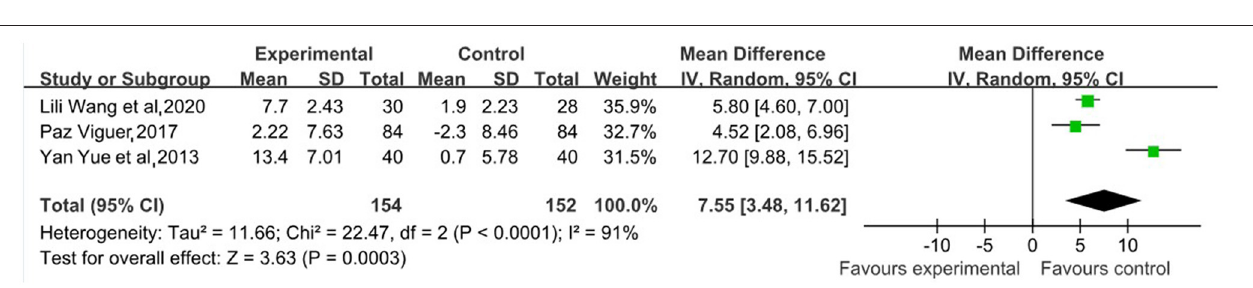
FIGURE 5 | Forest plot of the overall effect of reminiscence therapy on improving life